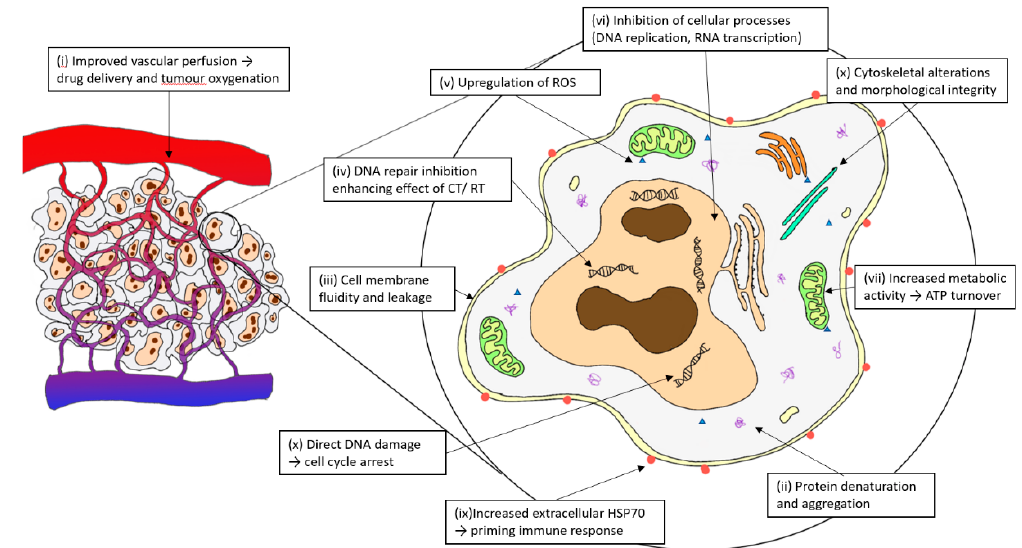
Figure 1. Biological mechanisms of hyperthermia.